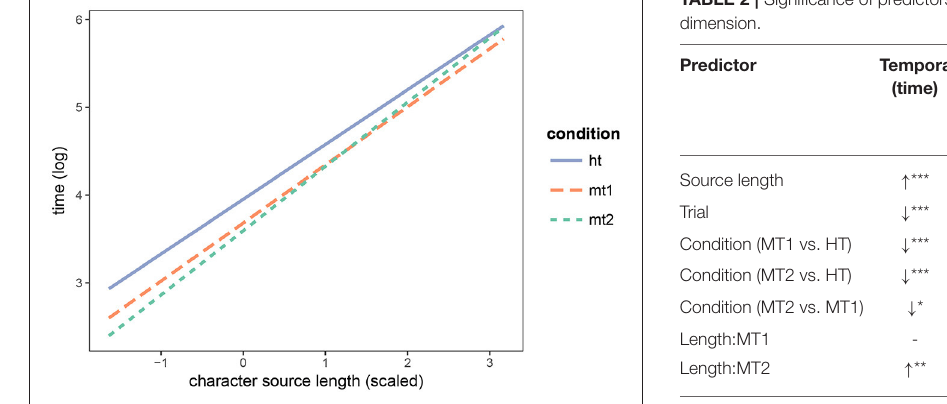
FIGURE 3 | Interaction between the length of the source sentence and the translation condition on temporal effort.